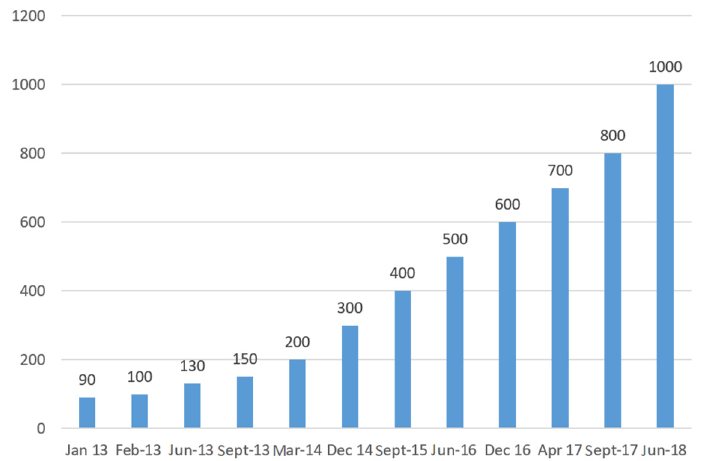
Figure 1. Instagram users from 2013 to 2018 (in millions). Sources Statista (2020).